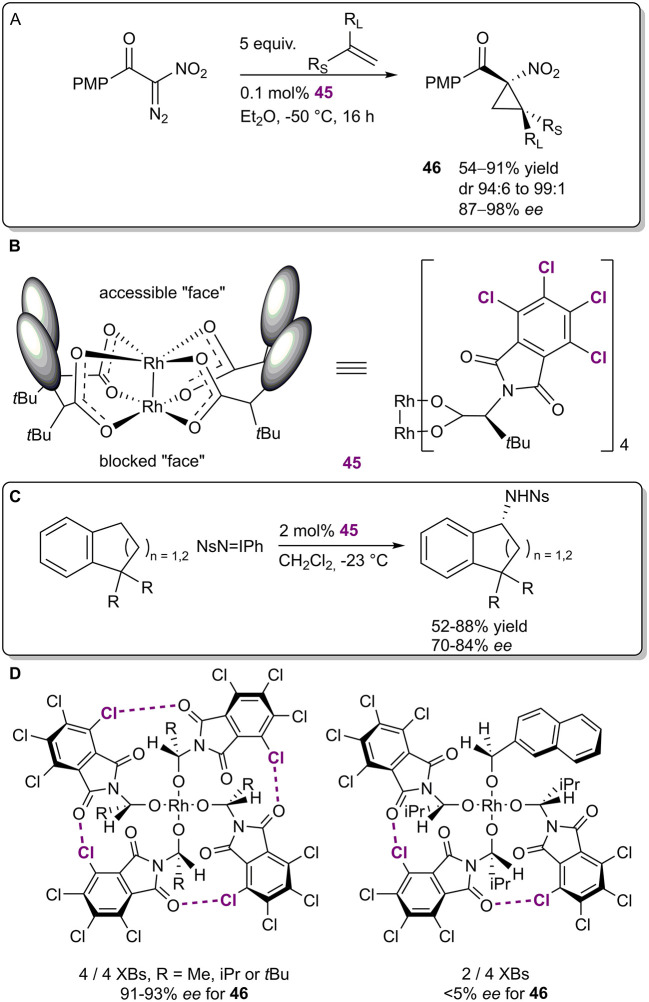
(A) Enantioselective Ru-catalyzed cyclopropanation; (B) structure of the Ru-catalyst 45; (C) enantioselective Ru-catalyzed amidation; (D) top view of two Ru-catalysts depicting the XB networks and their influence on the selectivity of the cyclopropanation.